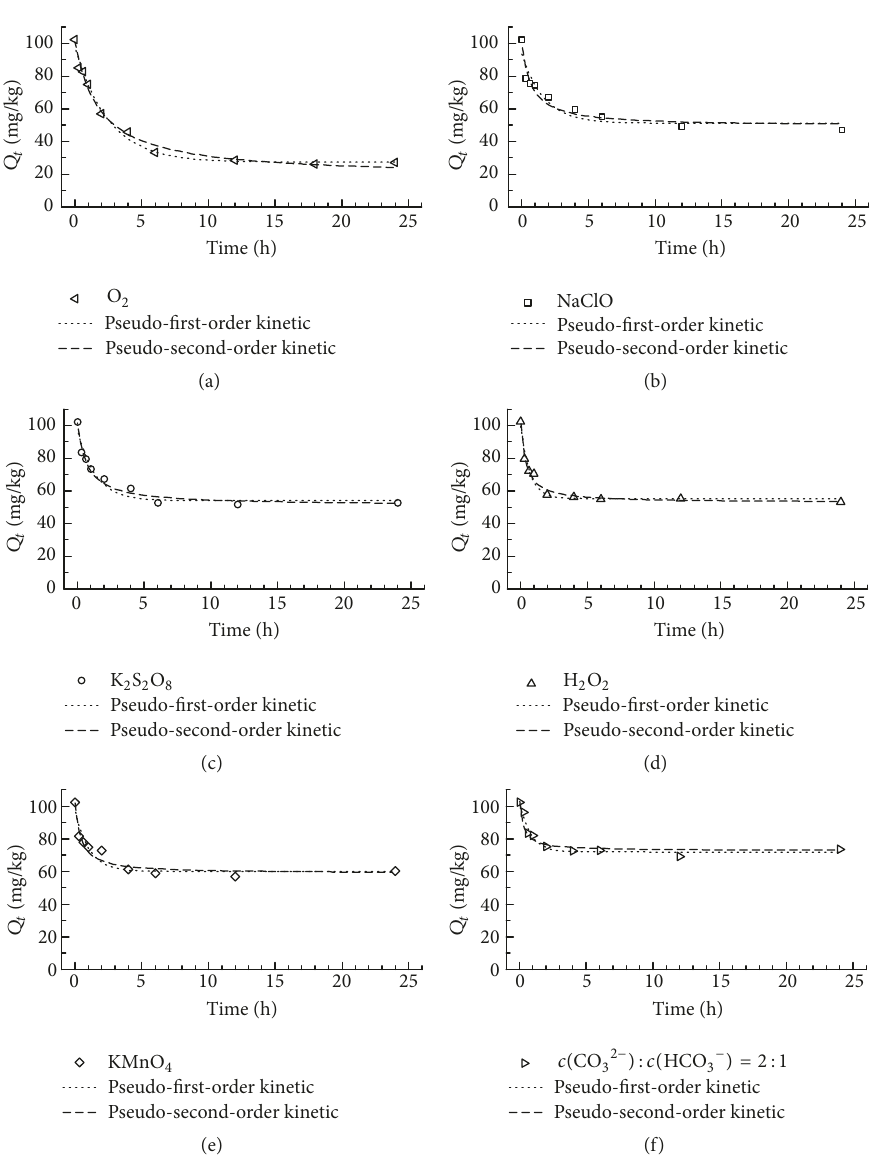
Figure 6: Kinetics of the leaching of uranium from the